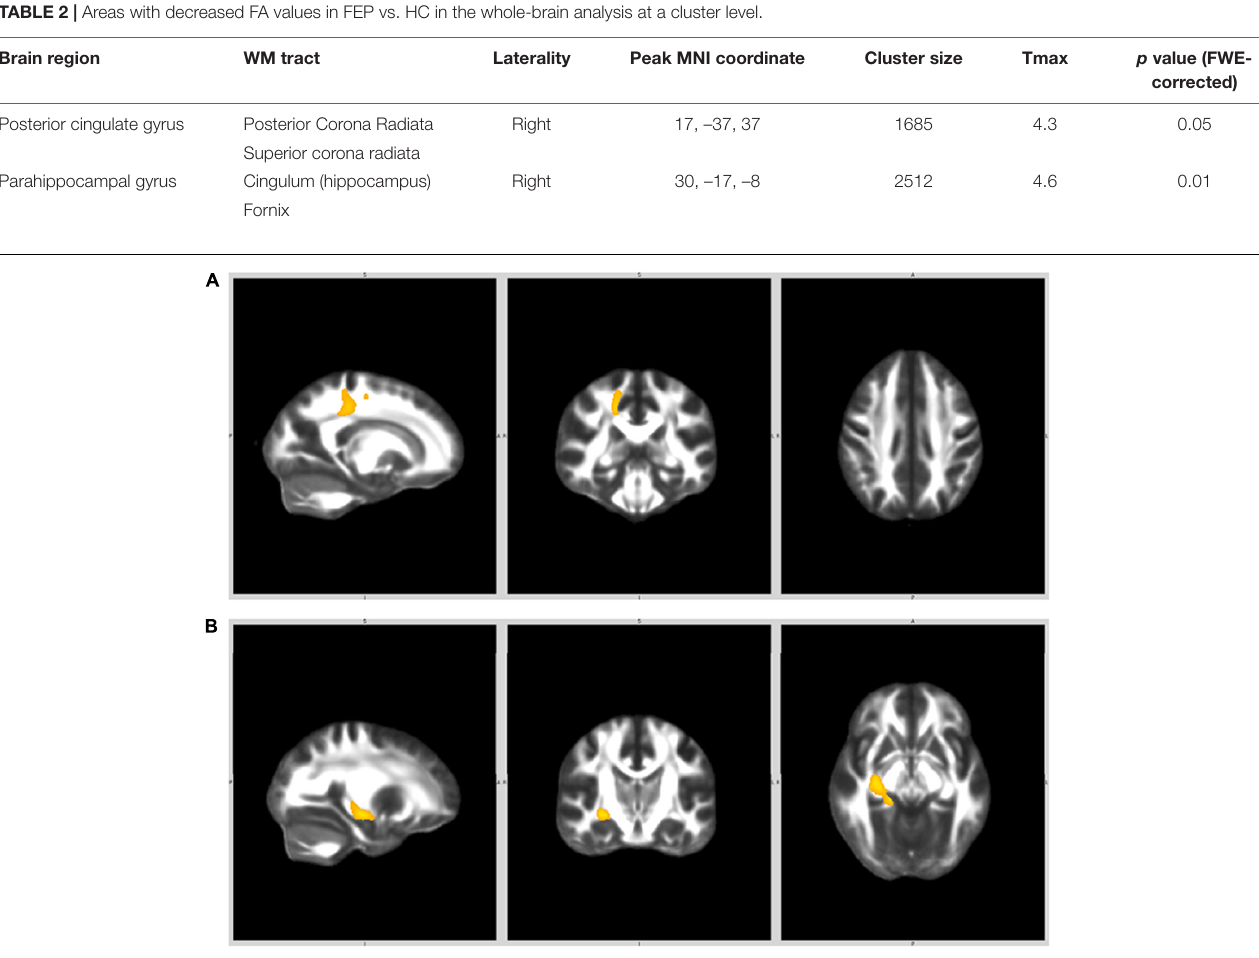
FIGURE 1 | White matter clusters where FA was significantly lower in FEP compared to HC. (A) Right posterior cingulate gyrus (right superior and posterior corona radiata). (B) Right parahippocampal gyrus (cingulam,